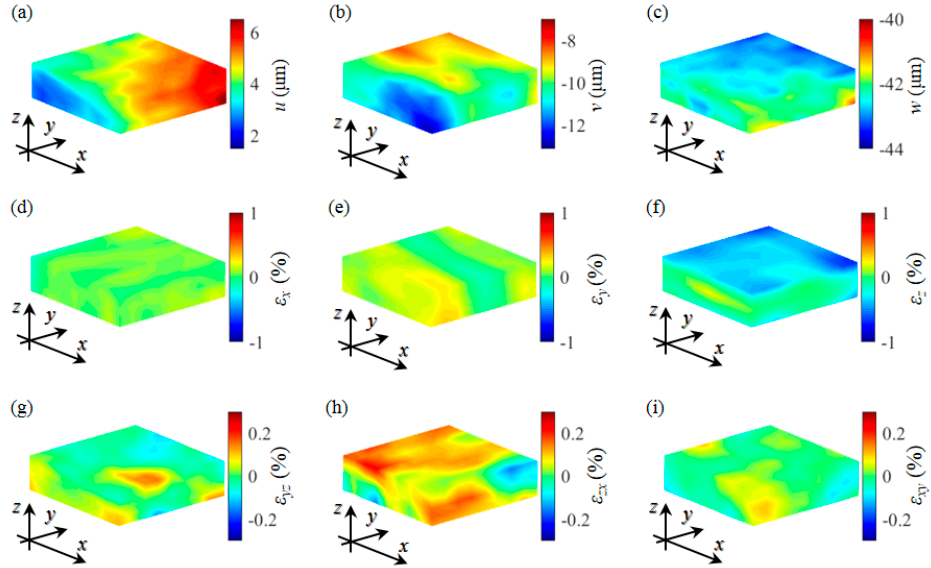
Figure 4. 3D deformation measurement of the homogeneous phantom. ( a – c ) 3D displacements in the x , y and z directions respectively; ( d – f ) 3D normal strains in the x , y and z directions respectively; ( g – i ) 3D shear strains.